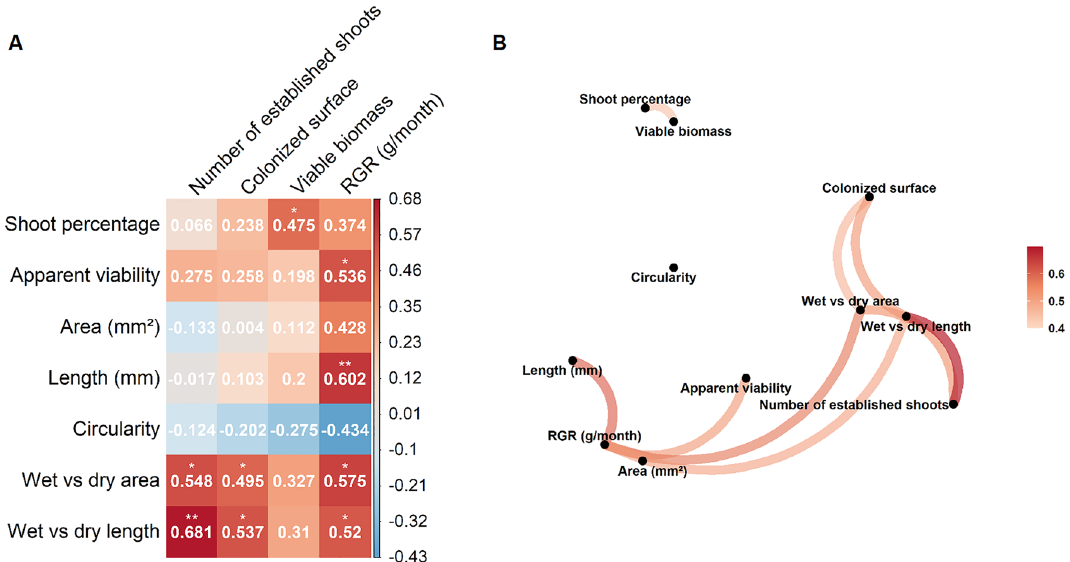
Figure 2. Correlations between the analysed traits and the indicators of establishment success. ( A ) Matrix of Pearson correlation coefficients. Correlations vary from red (+) to blue (−). Some indicators were previously transformed (see “Methods”). RGR stands for Relative Growth Rate. * p adjusted-values < 0.05, ** p adjusted- values < 0.01. ( B ) Network plot for Pearson correlations. Links between points represent correlations. Only significant correlations are depicted (note that in this particular case all significant correlations are positive). Some indicators were previously transformed (see “Methods”). Indicators and traits are clustered according to their correlation coefficients: the proximity of the points are determined using multidimensional clustering. The appearing plot conditions for correlations are: (1) p adjusted-values < 0.05 and (2) R > 0.4. For the correlation values see A. For more detailed representations of the correlations shown, see Fig.